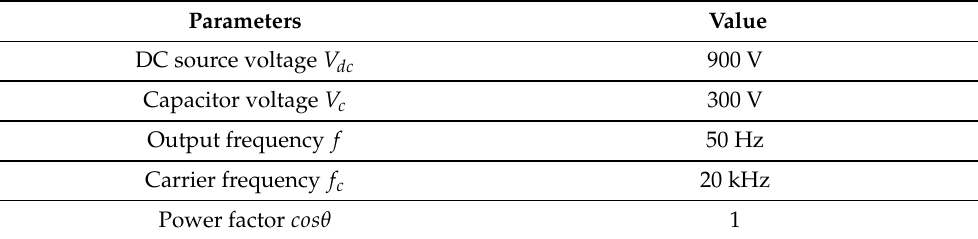
Table 1. Parameters of Simulated ACHB system.